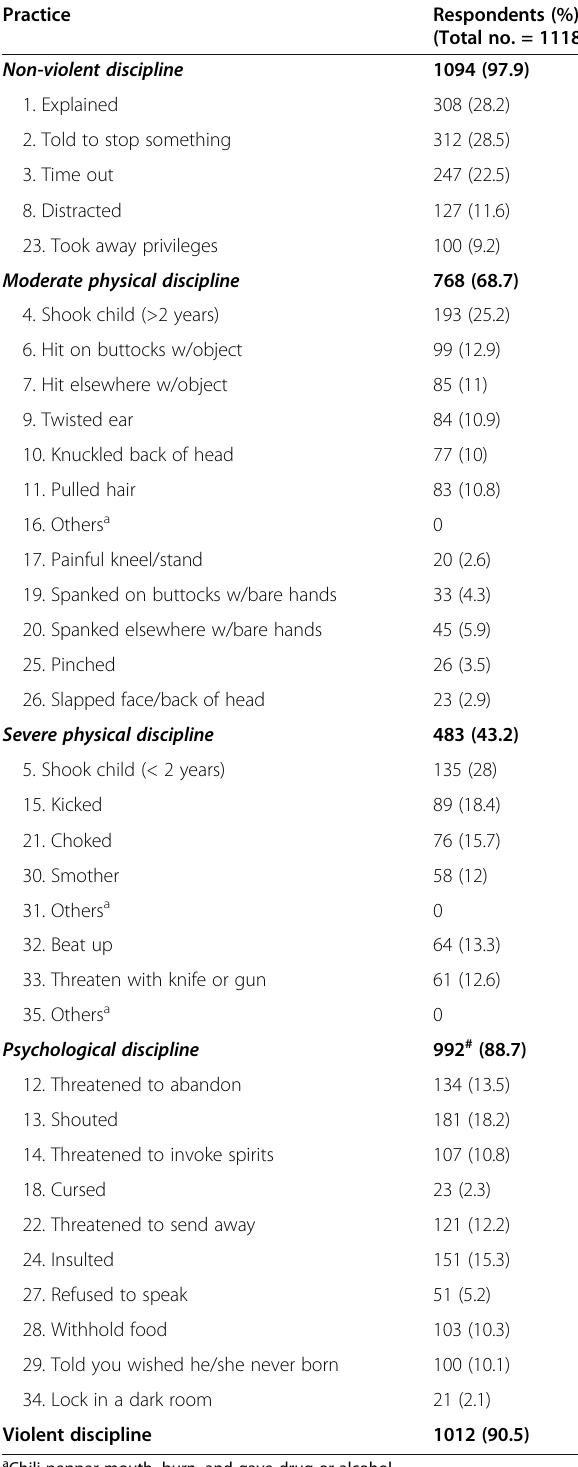
Table 3 Reported discipline practice of parents toward their children during COVID-19 pandemic using adapted ICAST-P in Sohag governorate, Egypt,